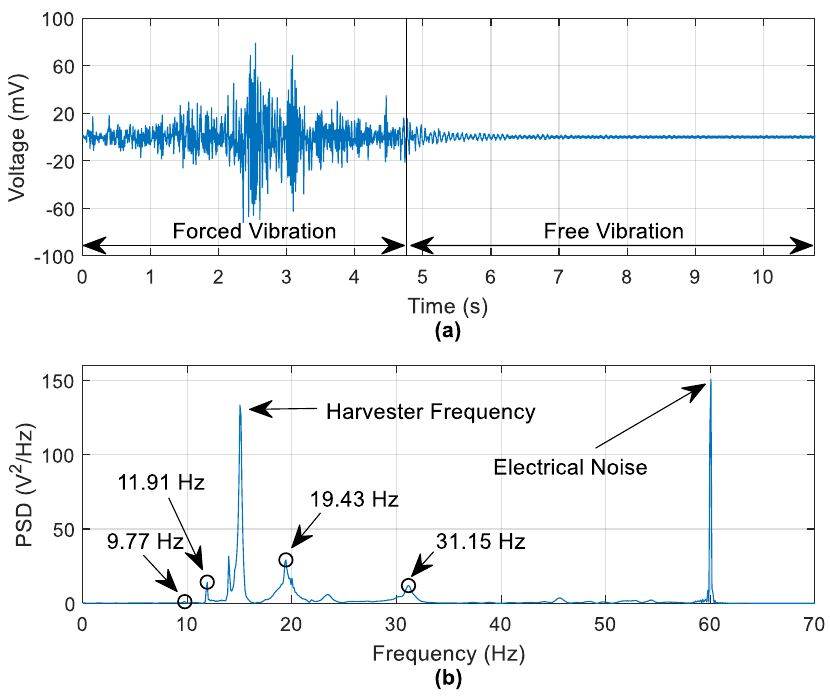
Figure 14. Energy harvester voltage data—( a ) Harvester voltage, ( b ) PSD of free-vibration voltage data.